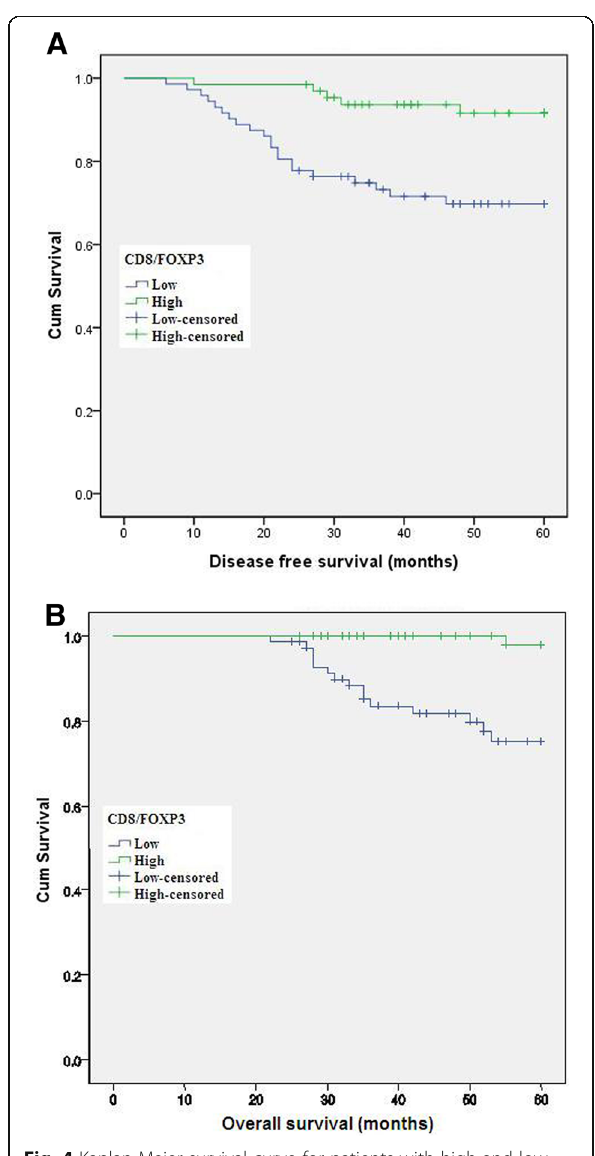
Fig. 4 Kaplan-Meier survival curve for patients with high and low CD8/Foxp3 level. The ratio of intratumoral CD8+/peritumoral FOXP3 + cells in residual tumors after NACT was associated with favorable clinical outcomes ( a : PFS; b :